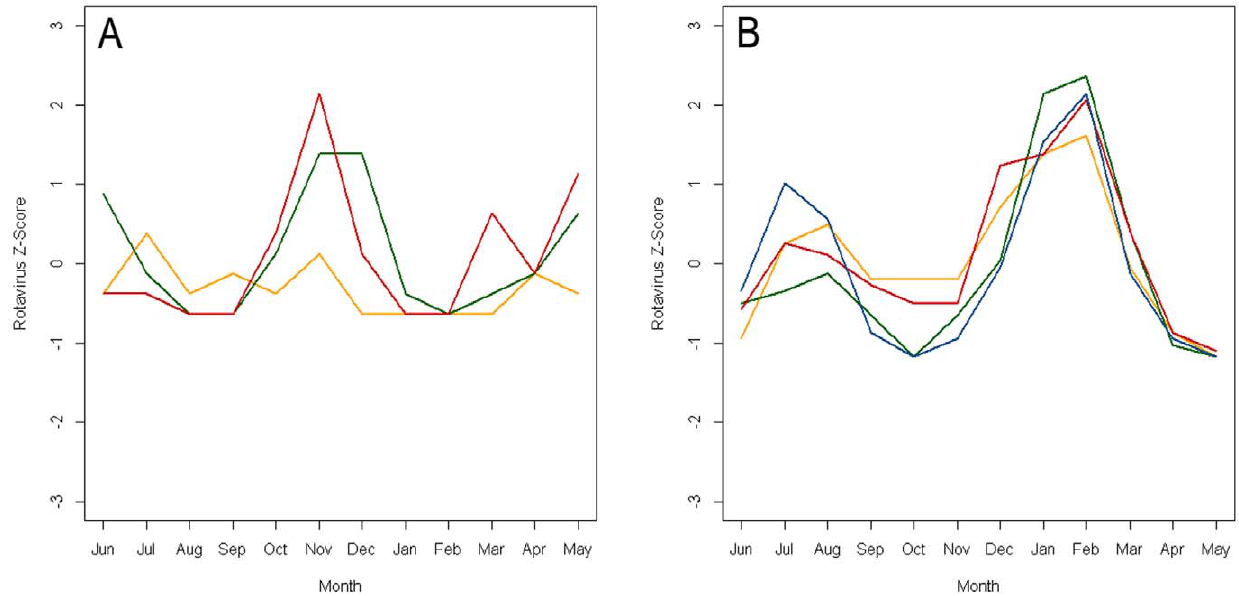
Figure 4. Annual time series of rotavirus z-score superimposed for years of the study for two locations. Panel A is data for a study conducted in Chandigarh, India [44] and Panel B is data for a study conducted in Matlab, Bangladesh [65]. Data are shifted by 6 months in order to center the winter peaks.